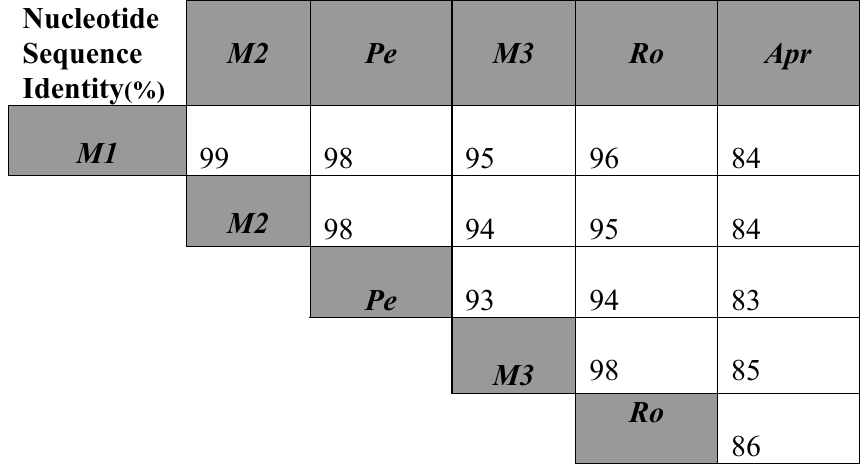
Table 1. Percentage of nucleotide sequence identity. The nucleotide sequence (about 600 base pairs long) of the amplified PCR products derived from the Prunus necrotic ringspot virus isolates M1, M2, M3, Pe, Ro and Apr were compared and % similarity between them